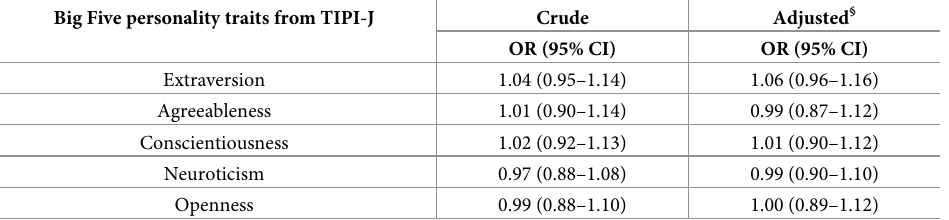
Table 3. Logistic regression results for association between the Big Five personality traits and food stockpiling for disaster (“stockpiling” vs “not stockpiling”) (n = 1192) † . Big Five personality traits from